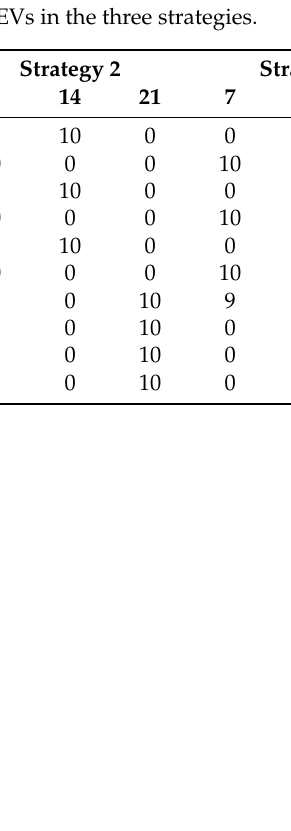
Figure 11. Schematic diagram of the optimal routes of every EV.